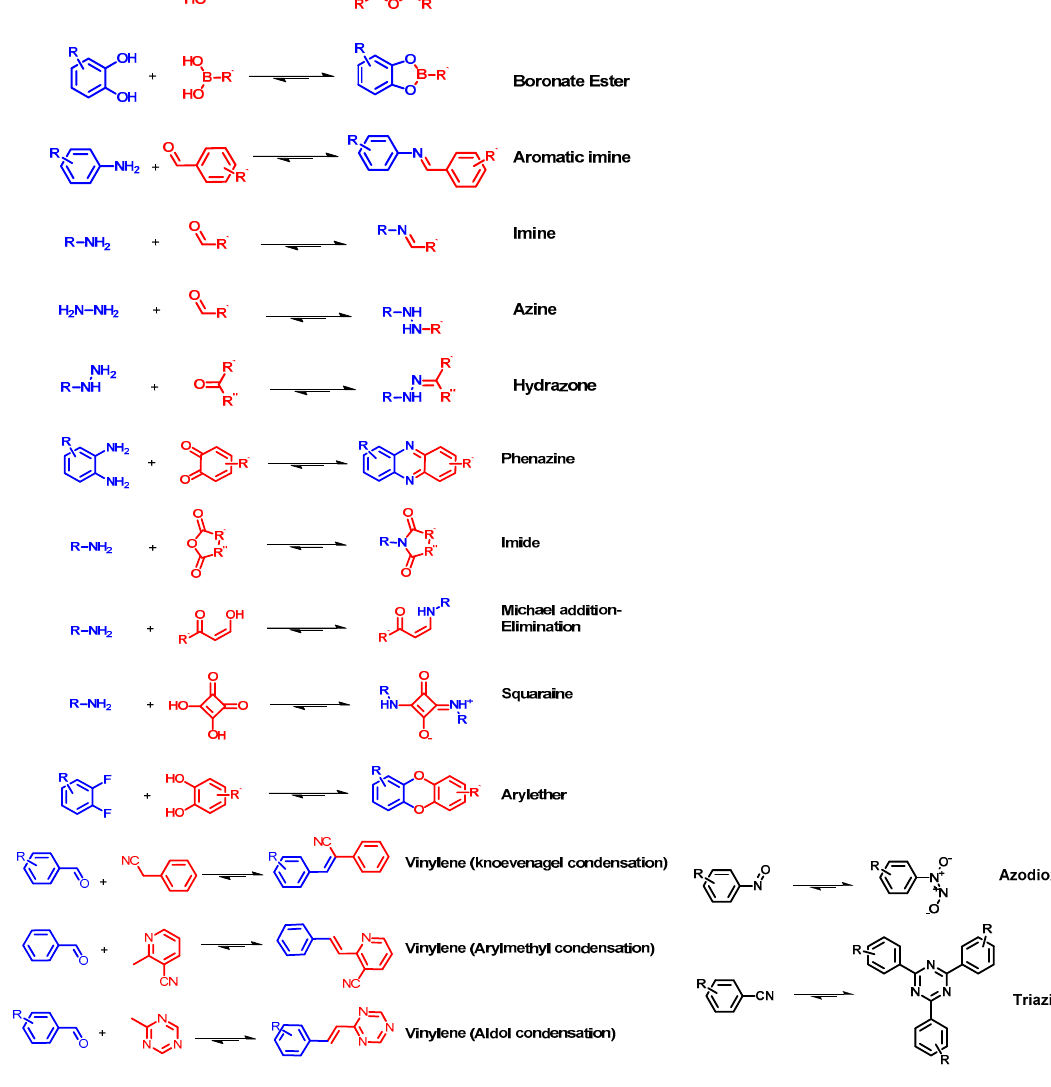
Figure 2. Reported linkage motifs for the realization of crystalline COFs. The reversible condensation reactions were used for the formation of a broad range of COFs .